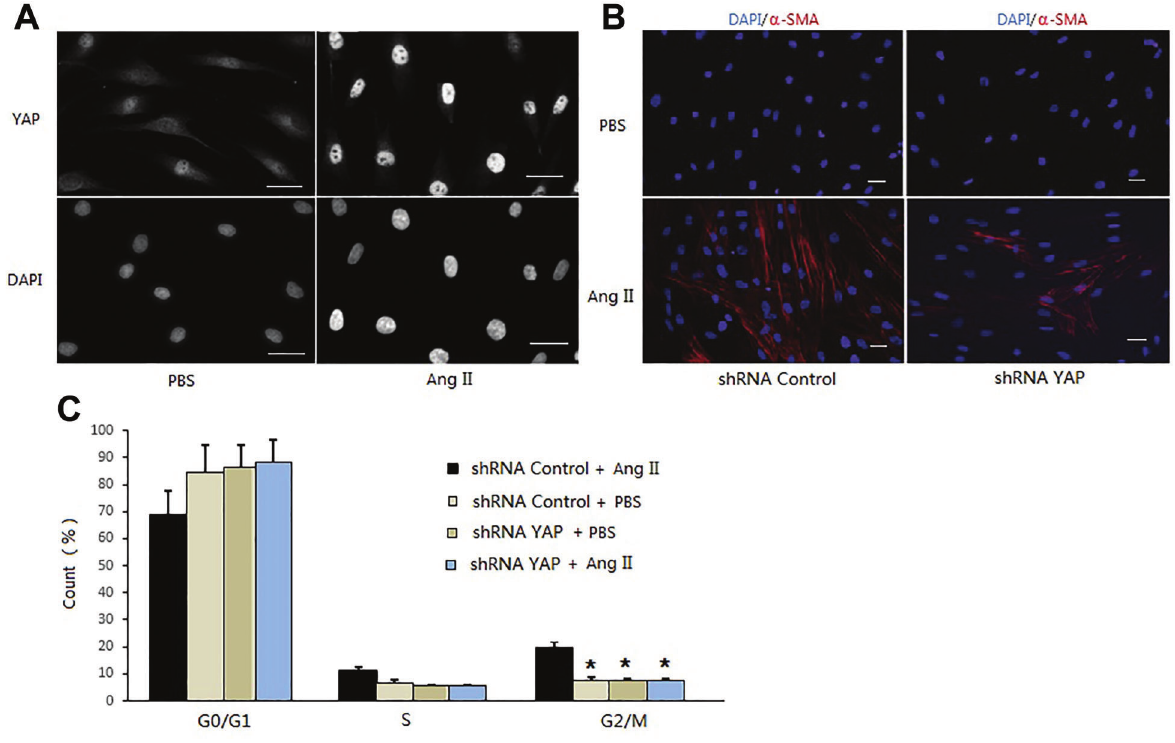
Figure 3. Yes-associated protein (YAP) was required for cardiac myo fi broblast transdifferentiation. A , Immuno fl uorescence staining of YAP and DAPI indicated that YAP was activated as seen by its nuclear localization in angiotensin II (Ang II-stimulated fi broblasts. B , a - smooth muscle actin ( a -SMA) expression at 24 h of Ang II stimulation was signi fi cantly lower after YAP knockdown, as shown by immuno fl uorescence of a -SMA (red) and DAPI (blue) staining. C , Cardiac fi broblast activation was inhibited by quantitative measurements of the percentage of cells in the G2/M phases of cell cycle using the Muse t cell analyzer. Data are reported as means ± SD. *P o 0.05 vs shRNA control + Ang II (ANOVA). Scale bar: 50 m m. Each experiment was conducted 3 times in